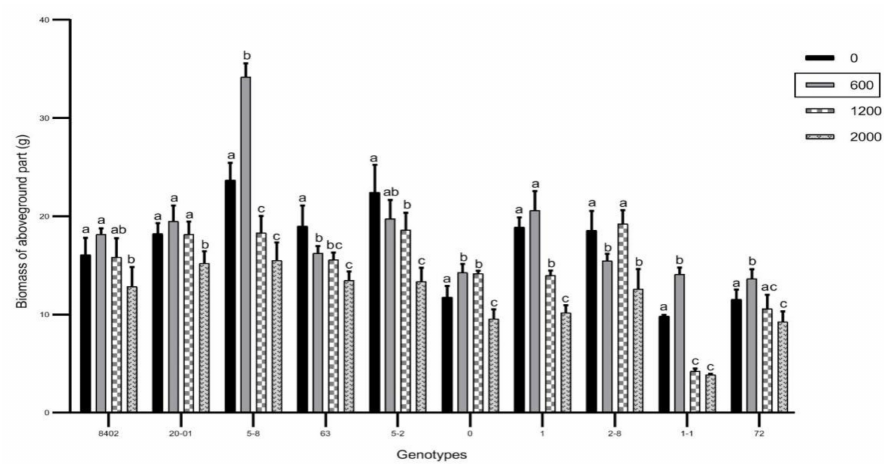
Figure 4. Effects of Sb concentration on the biomass of the aboveground part.